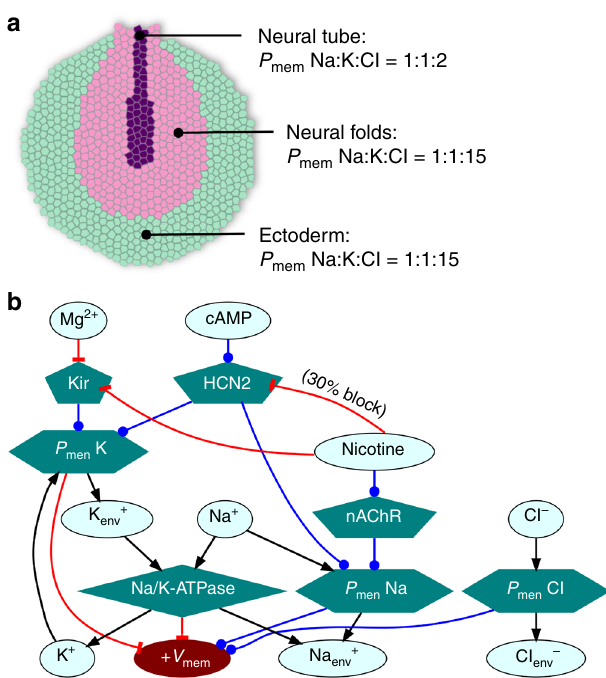
Fig. 2 BETSE model of endogenous resting potential gradients that instructively pattern embryonic neural tissue. a The BETSE model of neurula stage Xenopus embryo featured three different cell groups (referred to as tissue pro fi les) as indicated by color and labels. The neural tube pro fi le was made to have 5× higher leak membrane permeability to K + ions and 15× lower membrane permeability to Cl − ions, compared to the other two pro fi les, leading to hyperpolarized resting V mem in neural tube cells as has been experimentally observed 28, 48 . The model is assumed to be the outer layer of cells which face 0.1 × MMR. See supplemental document for detailed description of model. b The regulatory network describing the main components of the model. All cells of all simulations expressed equal levels of Na/K-ATPase ion pumps, inward-rectifying K + channels (Kir), and nAChR cation channels. Some simulations included HCN2 channels equally expressed on all cells, and/or nicotine introduced via